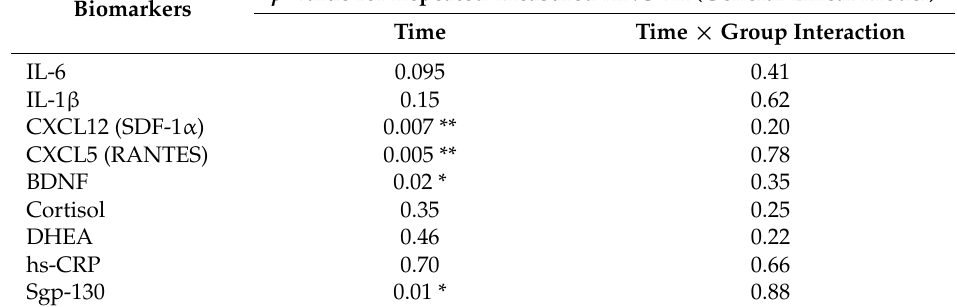
Table 3. Results from the analyses of biomarkers measurements at baseline, 3-months and 6-months post-intervention. p -Value for Repeated-Measured ANOVA (General Linear Model) Biomarkers Time Time × Group Interaction